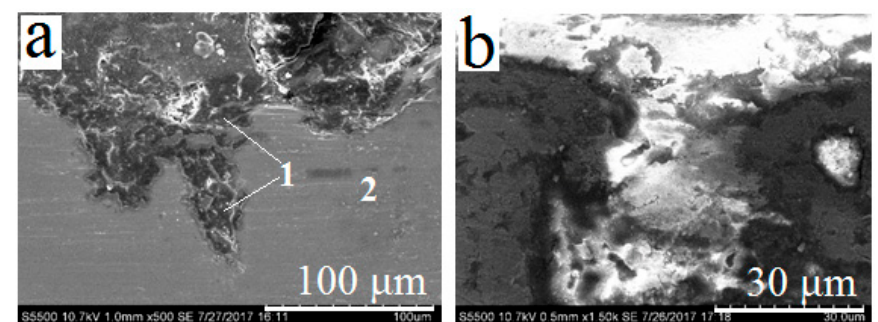
Figure 5. Cross-section of porous titanium samples (series 2) after coating. Magnifications: 500 × ( a ), 50,000 × ( b ).